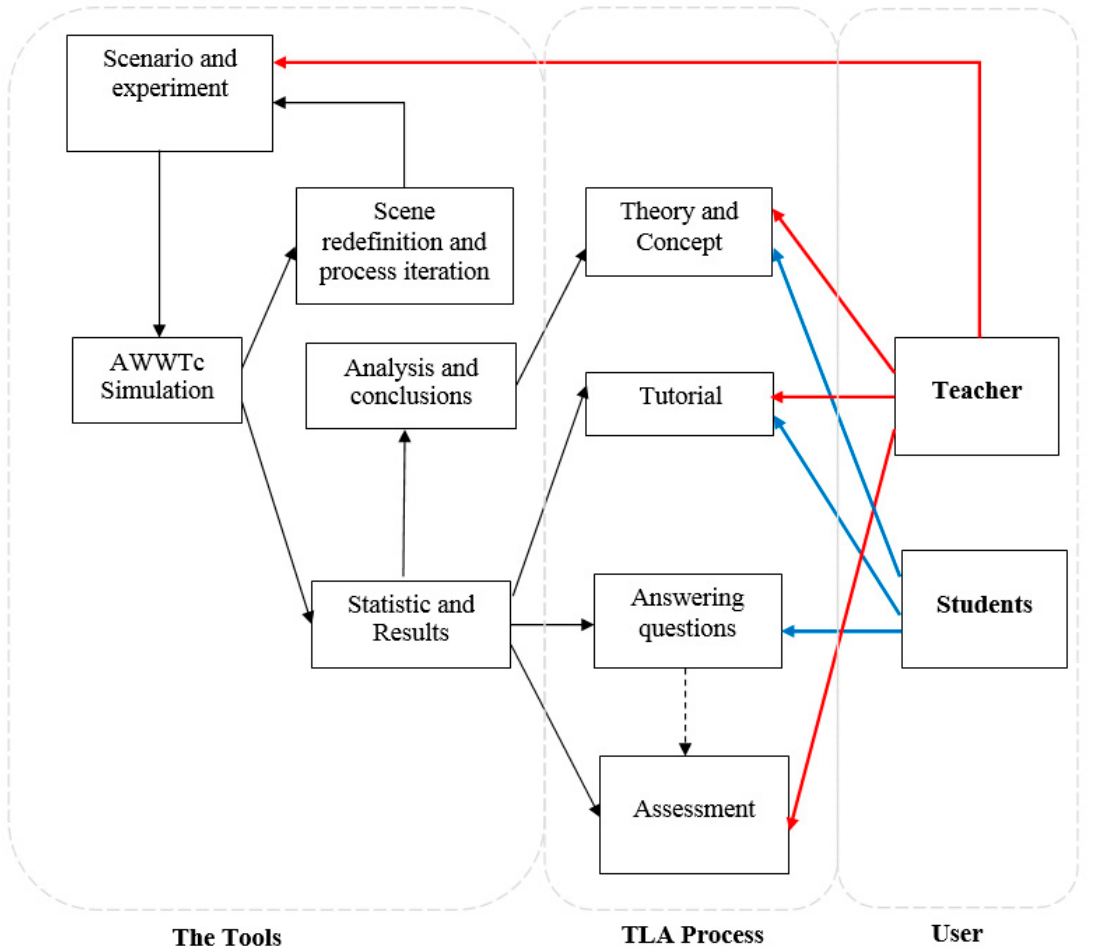
Figure 3. The check and balance approach in TLA